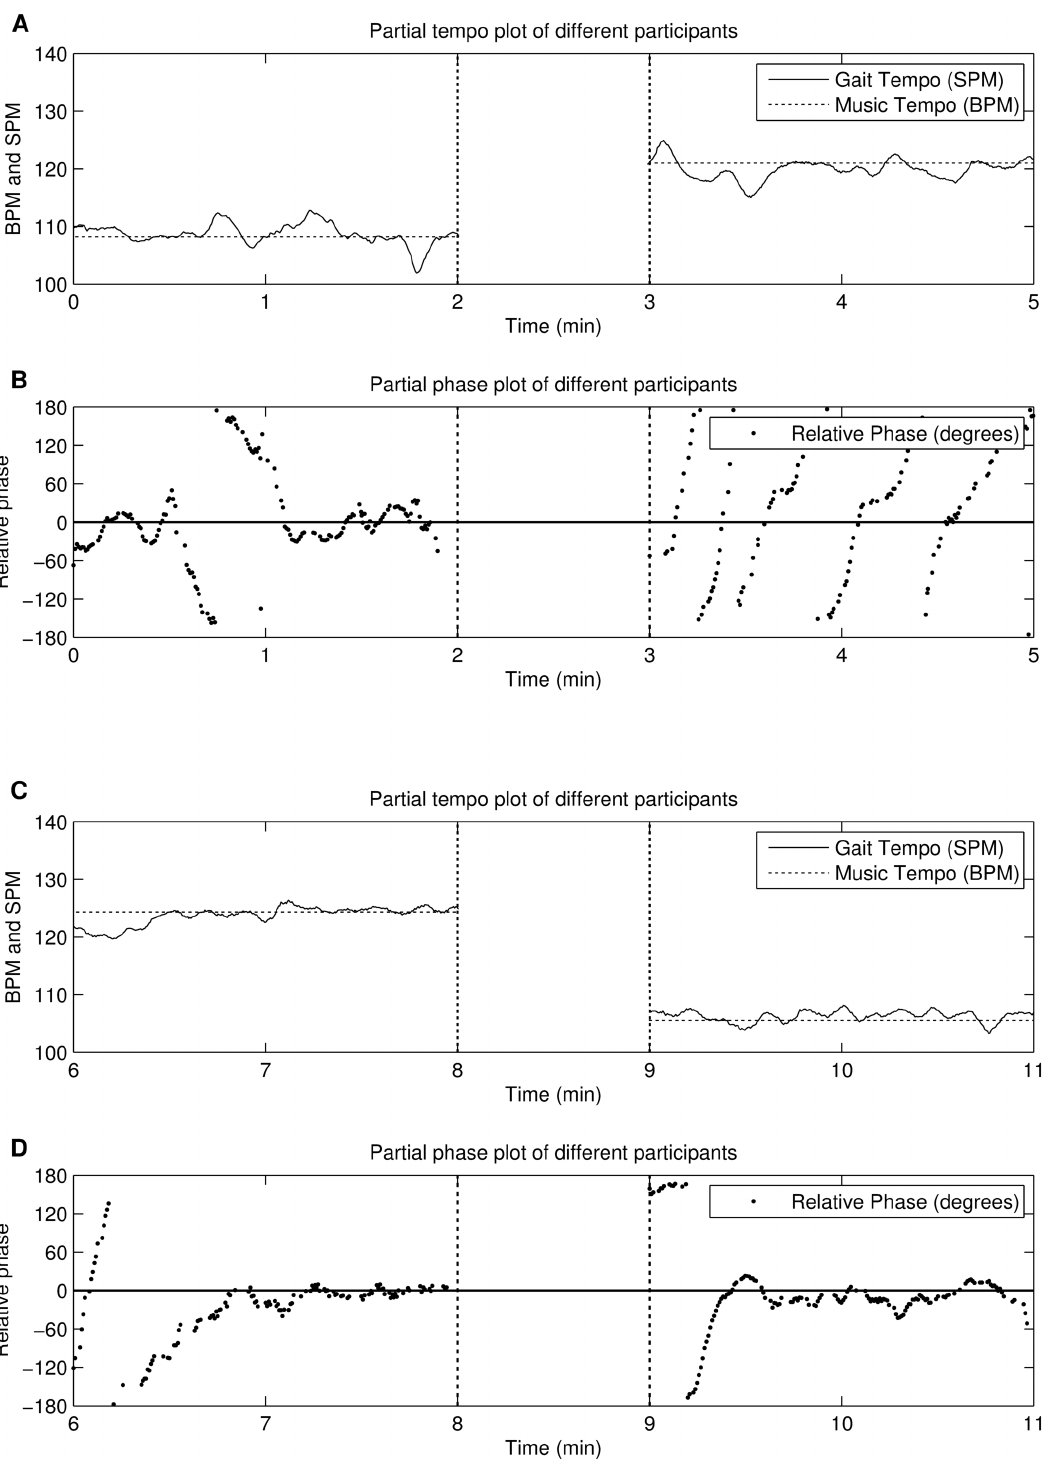
Fig. 9. Excerpts from the experiment of alignment strategy 2 (period-fixed phase-random). Figure A and C show tempo plots, figures B and D show the phase evolution per step. The figure shows several examples of recurring patterns throughout the